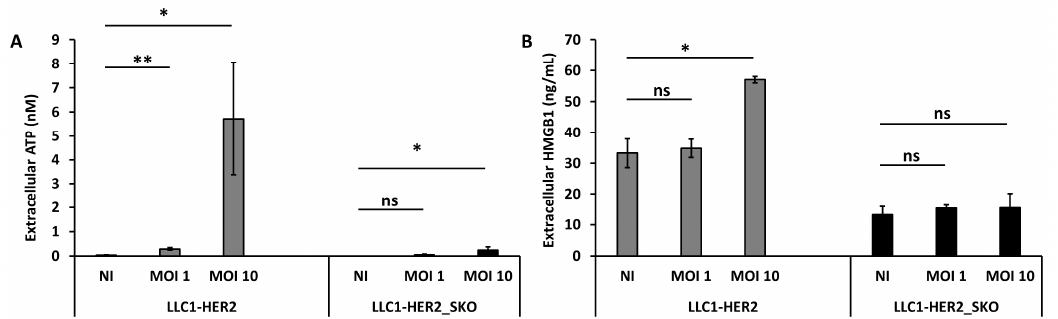
Figure 6. Sting expression in tumor cells is essential to induce oncolytic virus-mediated immunogenic cell death. Evaluation of extracellular ATP ( A ) and HMGB1 ( B ) released in supernatant of mock or OV (oncolytic virus)-infected LLC1-HER2 and Sting knockout cells. Viral doses are indicated in each panel (1 and 10 PFU / cell). Infections were performed as biological replicates. The statistical significances for experiments described in Figure 6 were calculated by Student’s t -test. Panel A, the p -values were: 0.0008 comparing untreated and 1 MOI LLC1-HER2; 0.01 comparing untreated and 10 MOI LLC1-HER2_SKO. Panel B, the p -value was 0.0199 comparing untreated and 10 MOI LLC1-HER2. Ns indicates statistically not significant di ff erences calculated by Student’s t -test. p < 0.05 *; p < 0.005